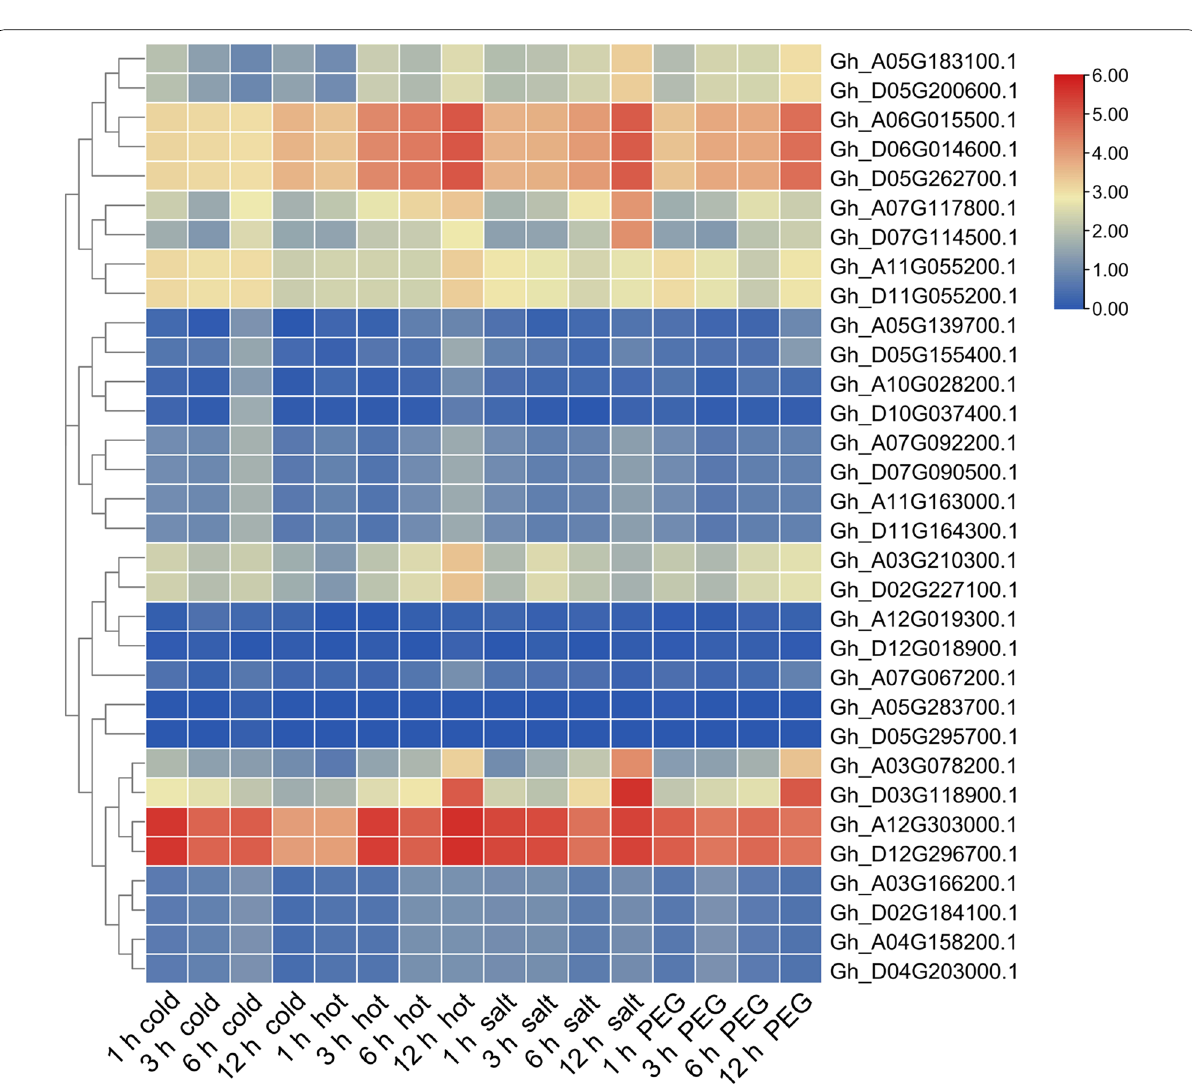
Fig. 6 Differentially expressed GhNAT genes under cold, heat, salt and PEG stress